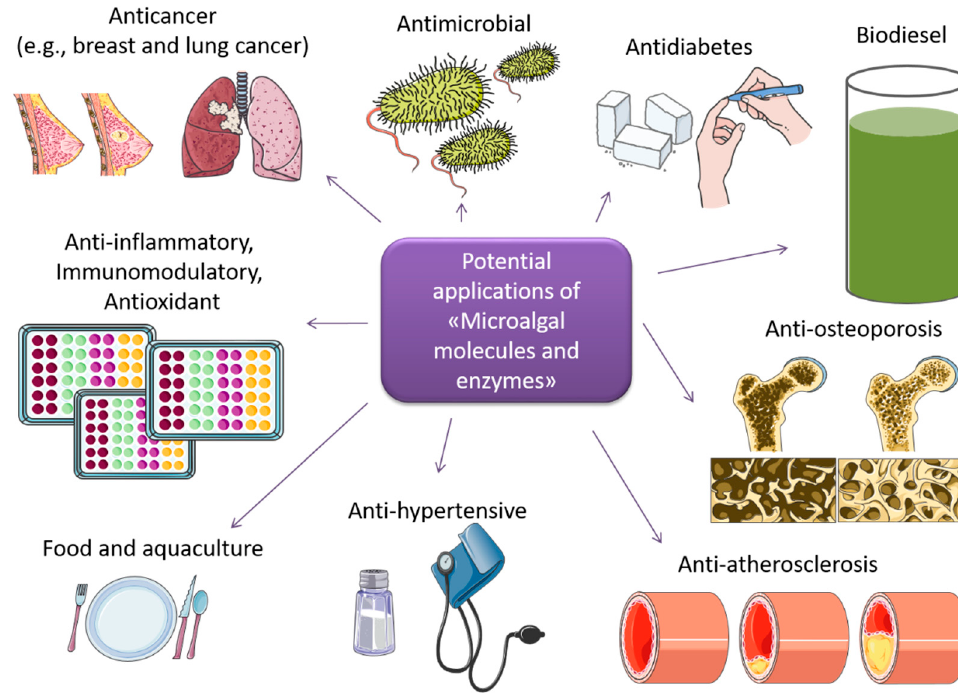
Figure 1. Possible applications of microalgal molecules and enzymes.